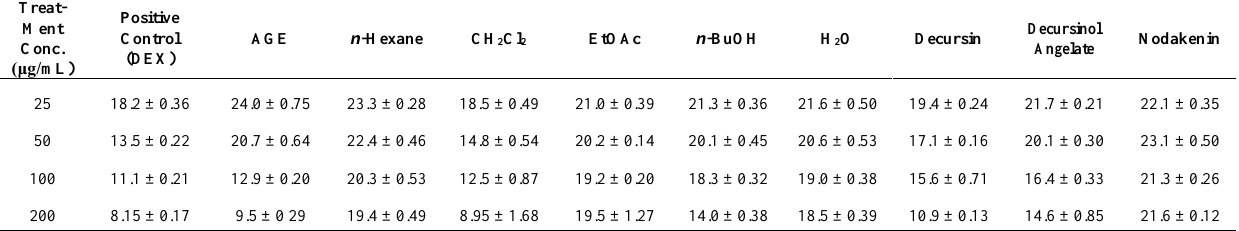
Table 1. The effect of A. gigas on the production of NO by Raw 264.7 cells in the presence of lipo-polysaccharide